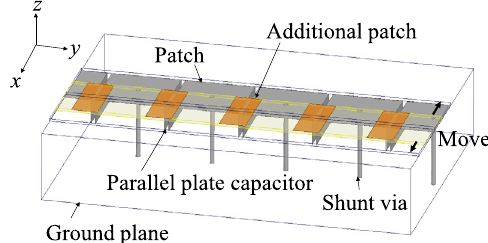
Fig. 3. Con fi guration of proposed phase